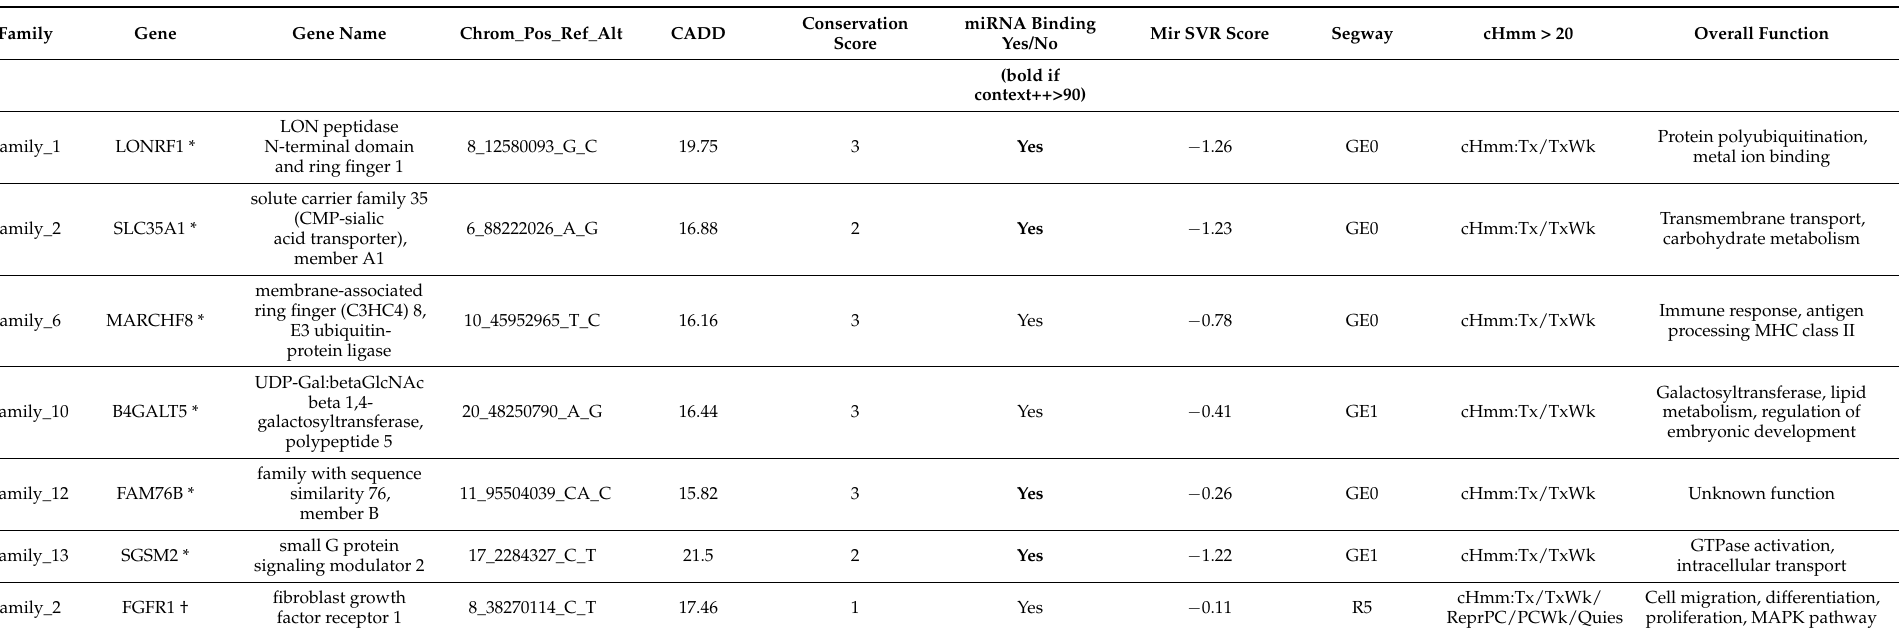
Table 2. The 3 (cid:48) UTR top and MAPK pathway variants prioritized based on FCPPv2 and non-coding variant analysis tools within CADD v1.6, and Uniprot/Swiss-Prot functional